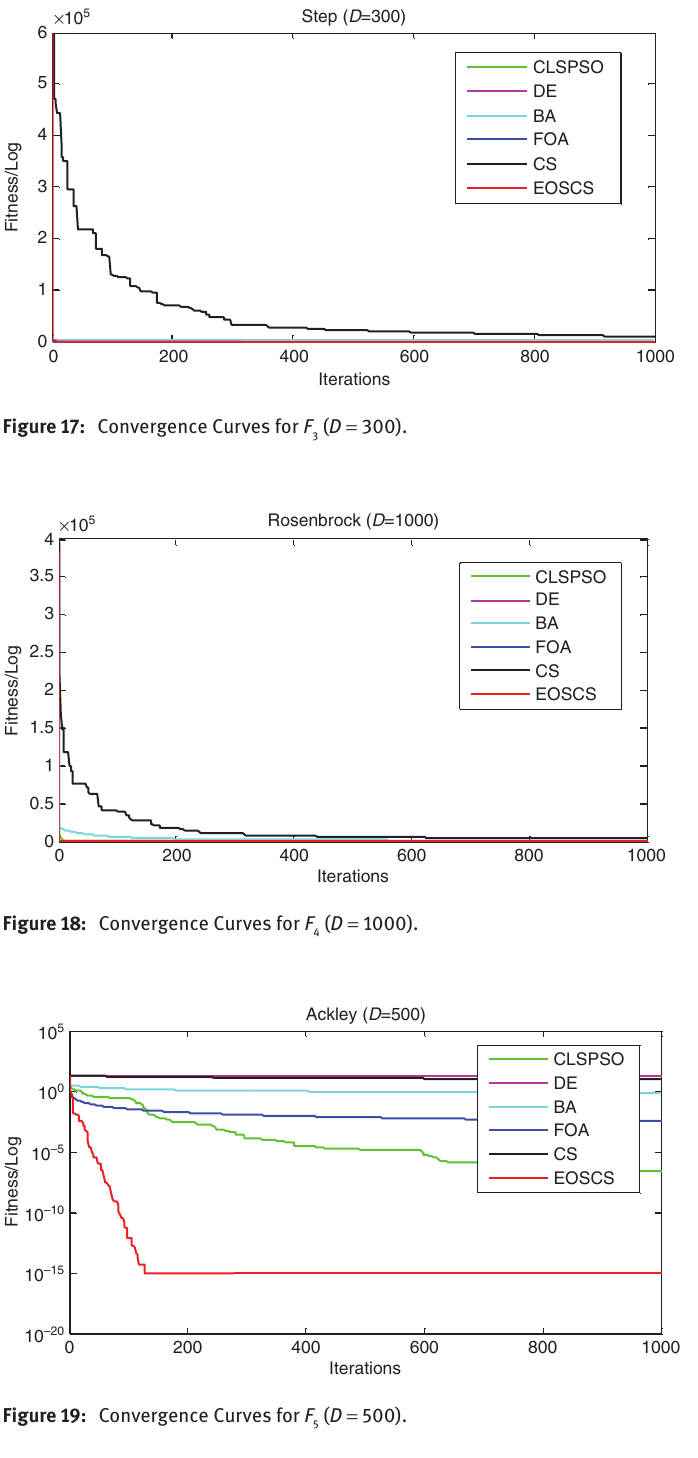
Figure 19: Convergence Curves for F